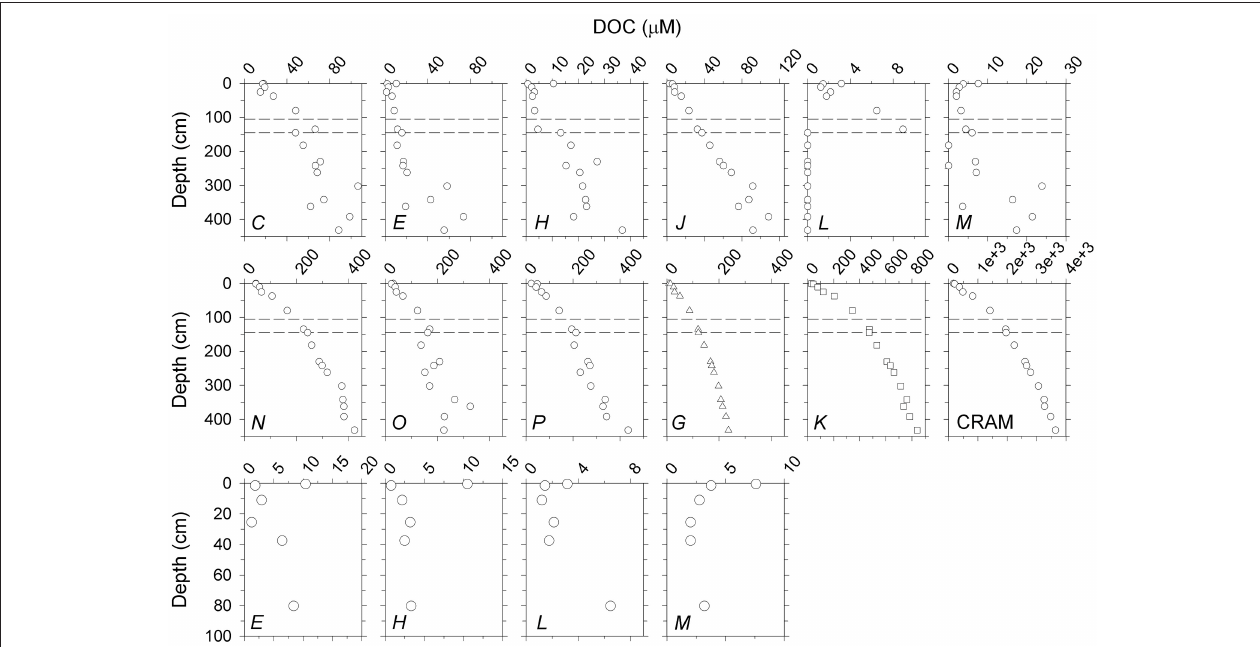
FIGURE 6 | Top two rows: DOC concentrations ( µ M) attributed to peaks ( C – M ), bands ( N-P , G , K ) and CRAM. Bands G and K are considered parts of CRAM. Third row: Close-ups of top 100cm of the profiles of E , H , L , and M showing local enrichment of these moieties at the sediment-water interface. DOC values were calculated from peak areas in the normalized spectra obtained on the 400 MHz instrument (Supplementary Material). Analogous profiles using data obtained on the 600 MHz instrument are shown in Supplementary Figure 3. Dashed lines indicate the upper and lower boundaries of the sulfate-methane transition zone (SMTZ, 125 ± 10cm; see section Group-2